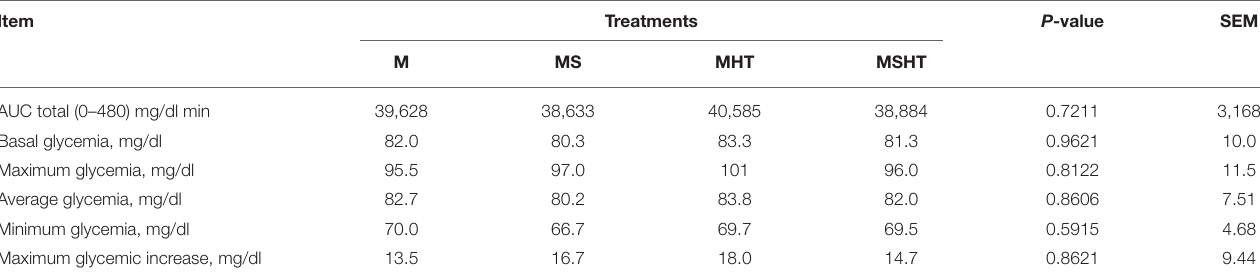
TABLE 7 | Area under the curve without basal glycemic area (AUC), plasma basal glucose concentration, plasma glucose concentration, and values of the glycemic peak of dogs fed the experimental diets. Item Treatments P -value SEM M MS MHT MSHT AUC total (0–480) mg/dl min Basal glycemia,